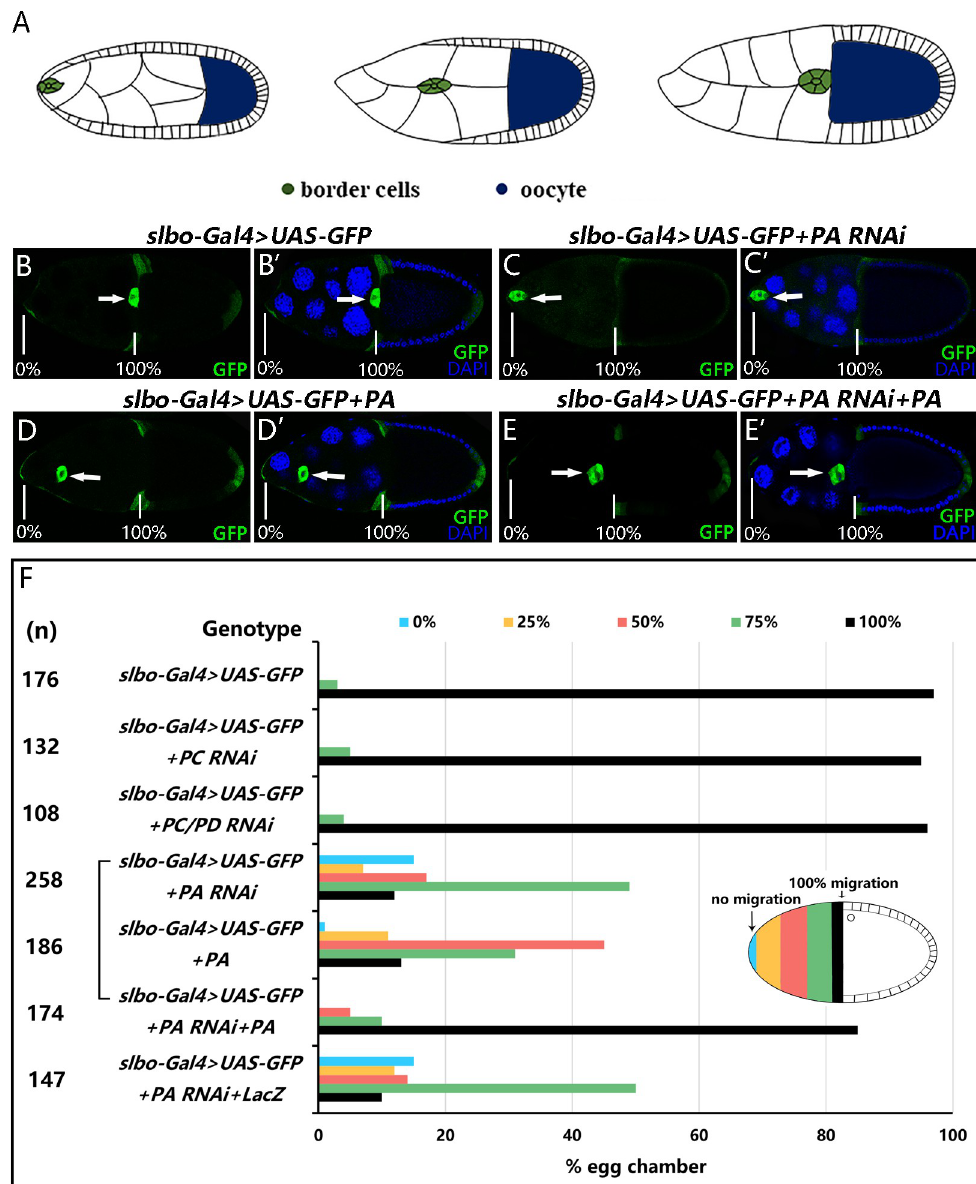
Fig 2. RhoGAP18B-PA regulates border cell migration. (A) A diagram of border cell migration. Border cell cluster migrates through nurse cells during stage 9, and reaches the border of oocyte at stage 10. (B-E’) Confocal micrograph of egg chambers at stage 10 are double labeled with DAPI (blue) for nuclei and with GFP (Green) to show the slbo-Gal4 expression patterns. The arrows show the positions of the border cell clusters. The percentage scale represents the beginning or ending positions of border cell migration. (B, B’) The control border cell cluster reaches the oocyte at stage 10. (C, C’) The knockdown of PA prevents border cell migration. (D, D’) The overexpression of PA impairs border cell migration. (E, E’) The border cell cluster expressing both PA RNAi and PA reaches the oocyte. (F) Quantification of border cell migration. The x-axis denotes the percentage of stage 10 egg chambers for each genotype with each degree of migration. The extent of migration for all stage-10 egg chambers examined is measured as 0–5% (blue, no migration), 6–25% (yellow), 26–50% (pink), 51–75% (green), 76–100% (black, complete migration). The number of egg chambers examined for each genotype is given (n). Note that expression of PA efficiently rescues the migration defects caused by PA RNAi expression.